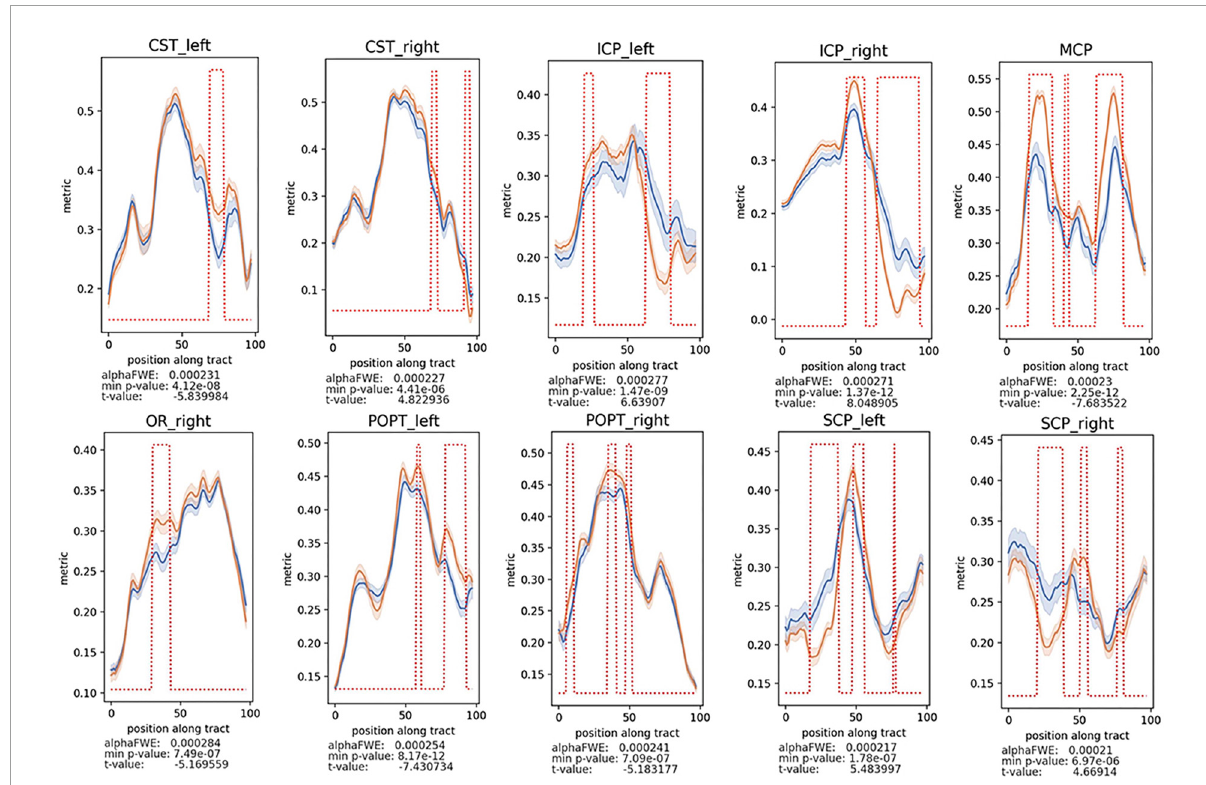
FIGURE3 Decreased FA values of the CST, cerebrospinal tract; MCP, middle cerebellar peduncle; ICP, inferior cerebellar peduncle; OR, optic radiation; POPT, parieto-occipital pontine tract; SCP, superior cerebellar peduncle, were found in patients vs. healthy controls ( P < 0.05, FWE-corrected). The alphaFWE is the alpha value corrected for multiple comparison (multiple parts per tract and multiple tracts). The min p -value is the minimal p -value which was calculated for each tract. If min p -value < alphaFWE, the tract contains significant results. The red dotted lines above of the lines of the patients’ group and the controls indicates all positions with the tract where p -value <